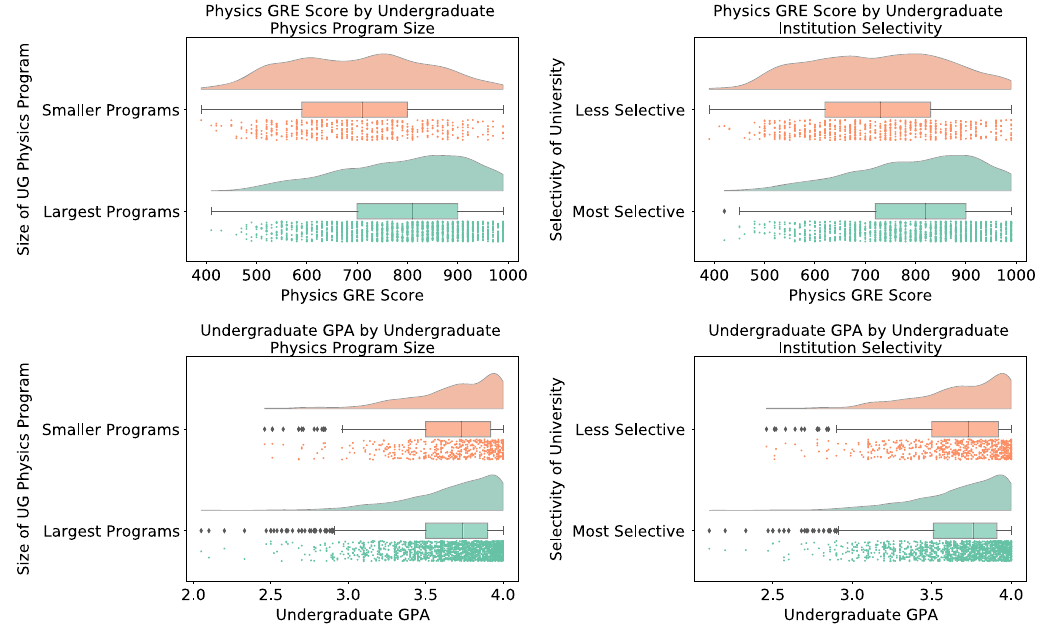
17. Distribution of physics GRE scores and undergraduate GPAs by the size of the undergraduate physics program and institutional selectivity for each